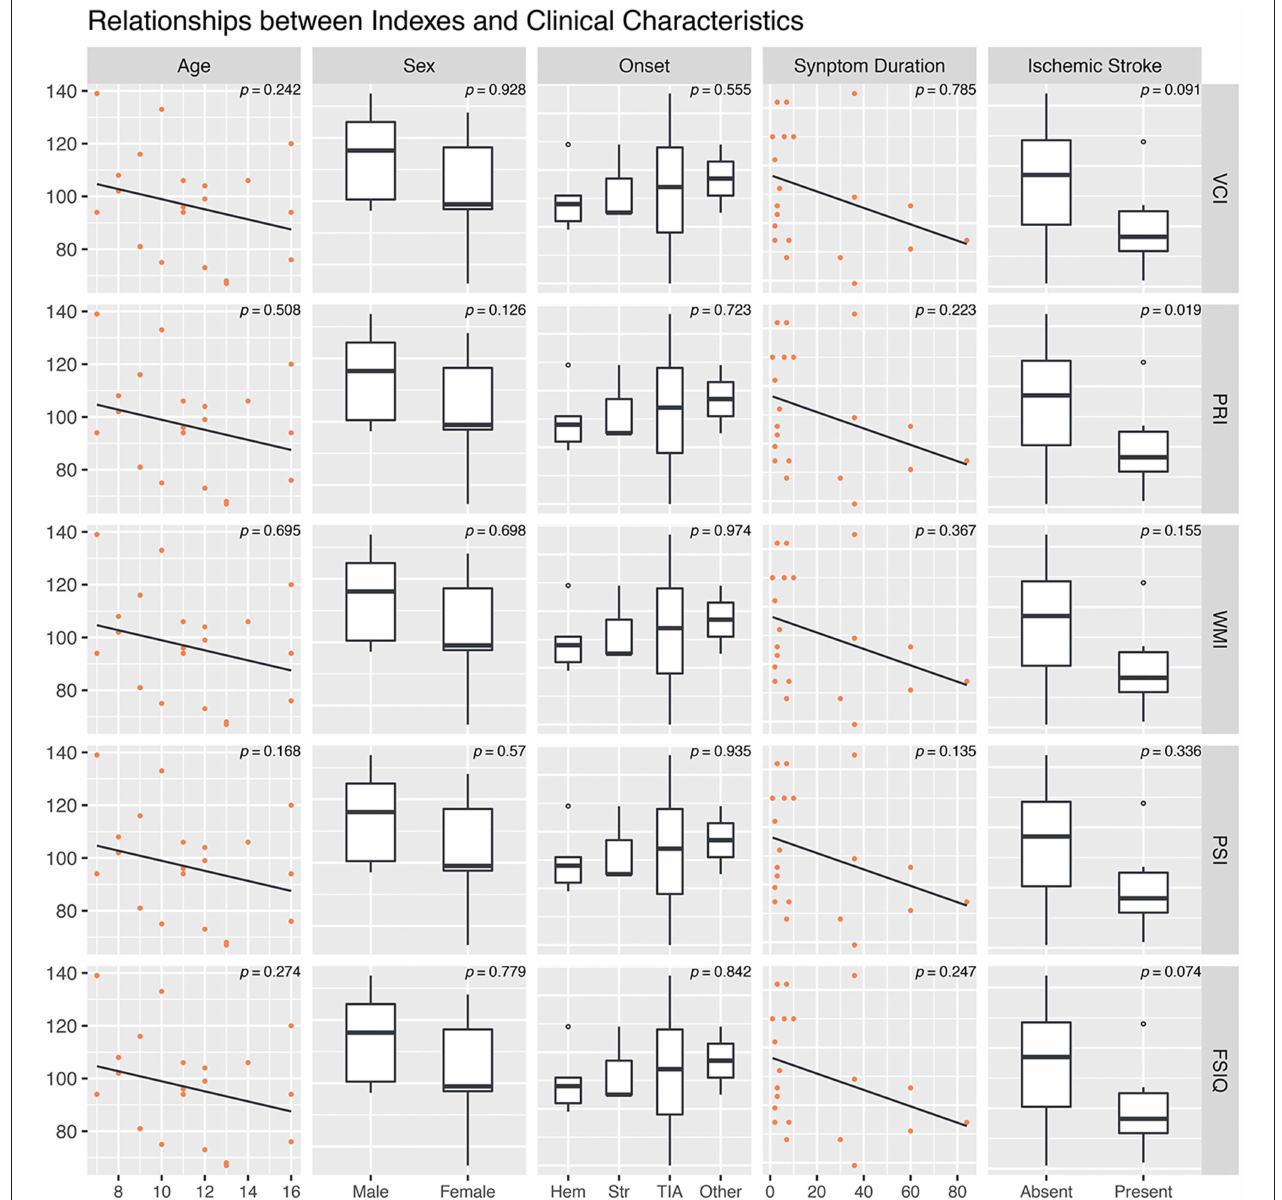
FIGURE 2 | Relationships between Clinical Characteristics and Cognitive Index